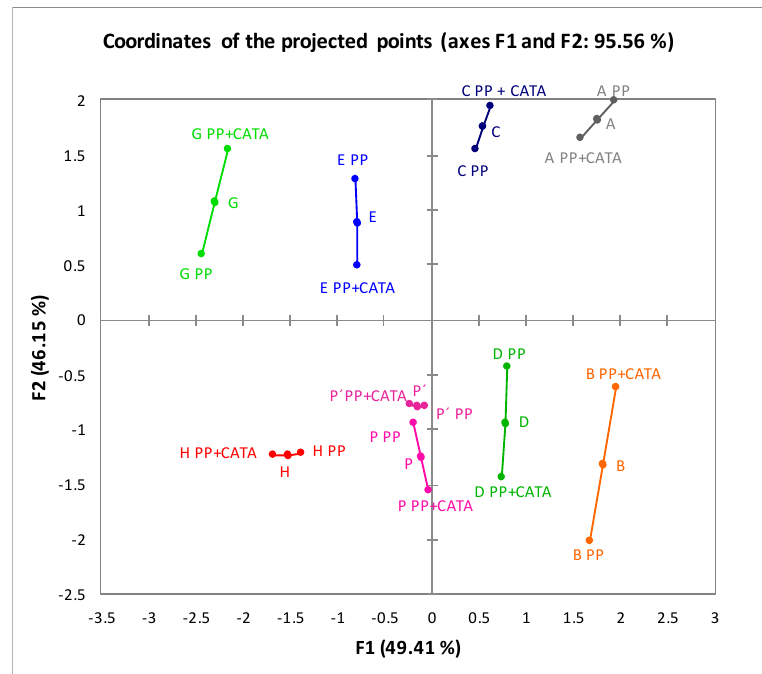
Figure 3. Representation of the superimposed samples in the MFA of both methodologies. All the samples are represented by two points corresponding to each applied methodology (PP and PP + CATA). In turn, a third point, which corresponds to the consensus representation and considers both instances of evaluation, is presented.